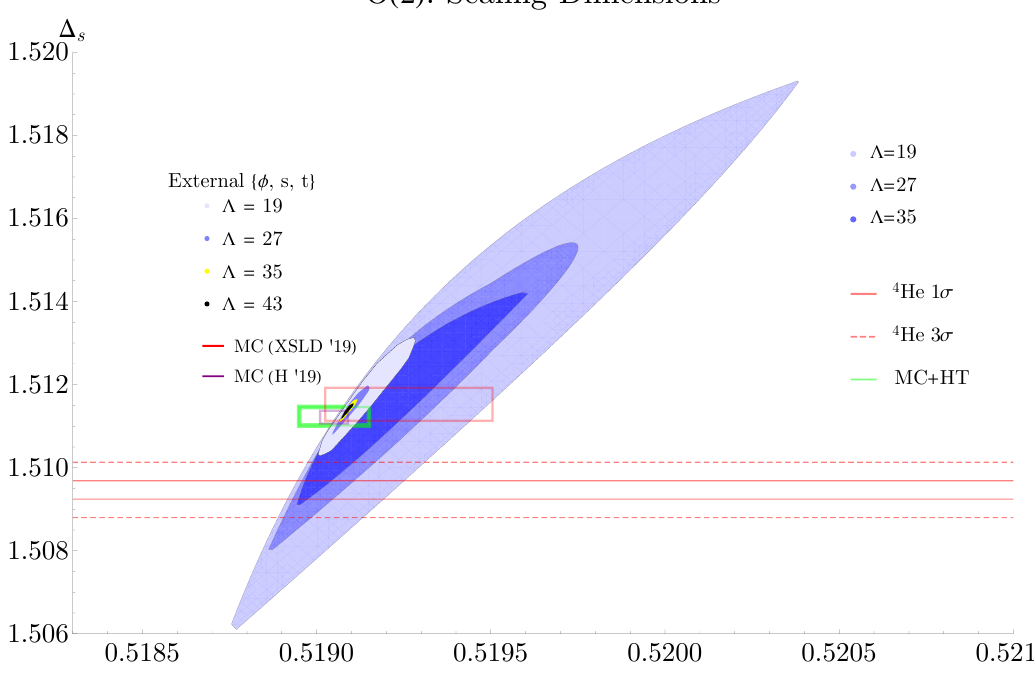
Figure 9 . Superposition of the new O(2) islands using the f (cid:30) i ; s; t ij g system and OPE scans over the earlier bootstrap results from [7] which used the f (cid:30) i ; s g system. rigorous error